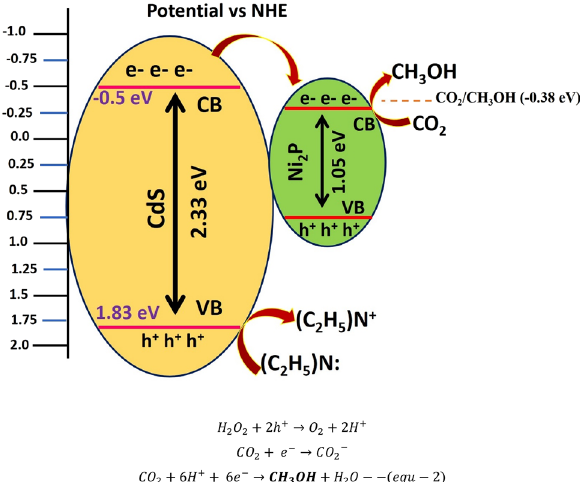
Figure 8. Probable mechanism of charge transfer and CO 2 reduction by 5 wt%-Ni 2 P/CdS composite and chemical equations. Comparision of Ni 2 P/CdS and Pt/TiO 2 for photoreduction of CO 2 to methanol is provided in Table 2. The synthesised 5% Ni 2 P/CdS photocatalyst in this work appears to outperforming the other reported photocatalysts.